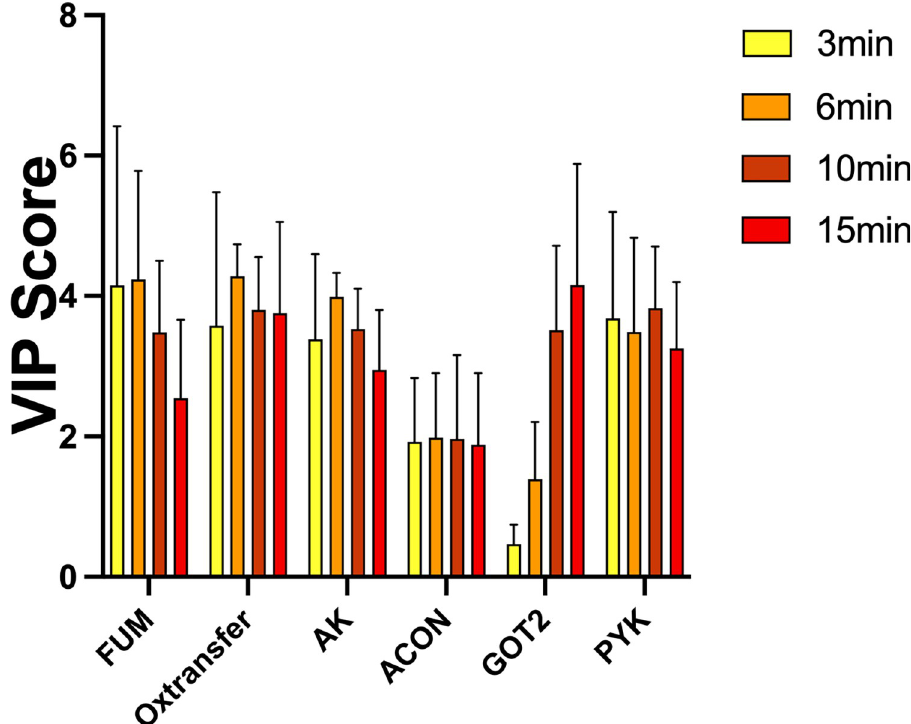
Fig 6. Short-term time course PLSR models. PLSR models were generated for each shorter time course of interest (3, 6, 10, and 15 minutes), correlating the average flux through each reaction with the insulin produced. The predicted VIP scores are shown for each time